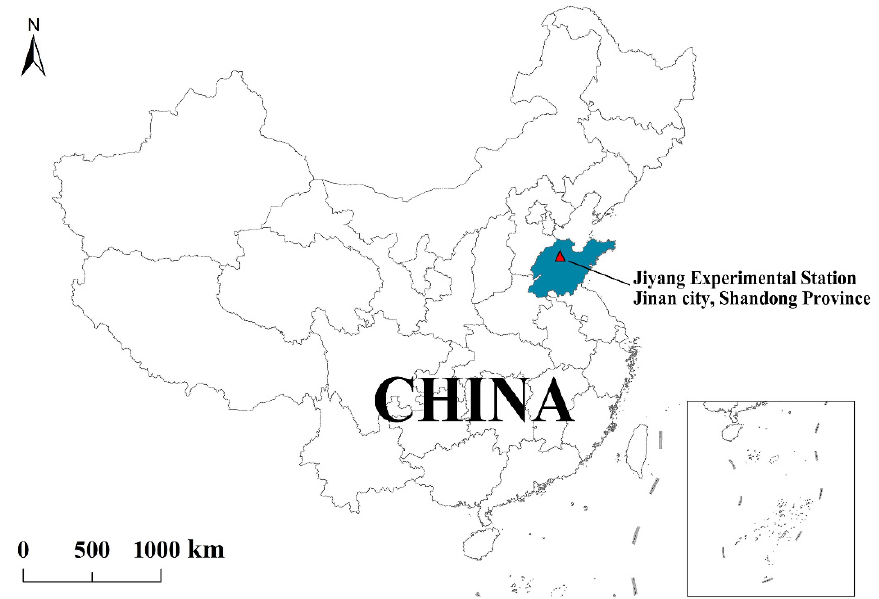
Figure 1. Map of Jiyang Experimental Station in Jinan city, Shandong Province, China.